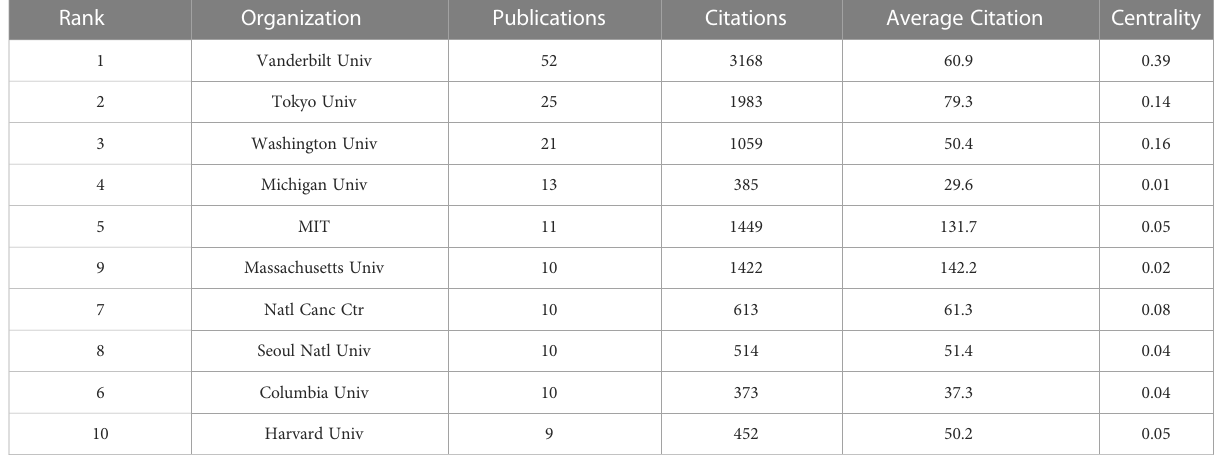
TABLE 2 The top 10 productive organizations involved in SPEM-GC